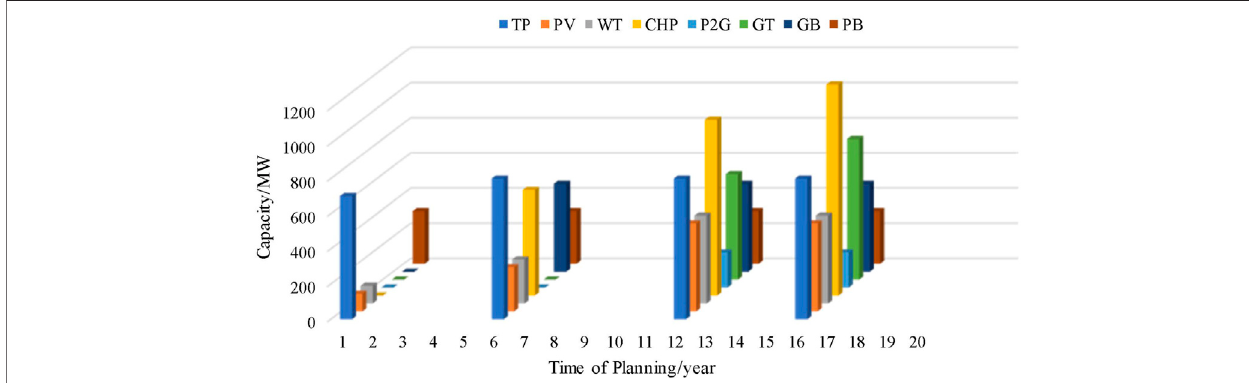
FIGURE 6 | Planning and configuration results in case 1.